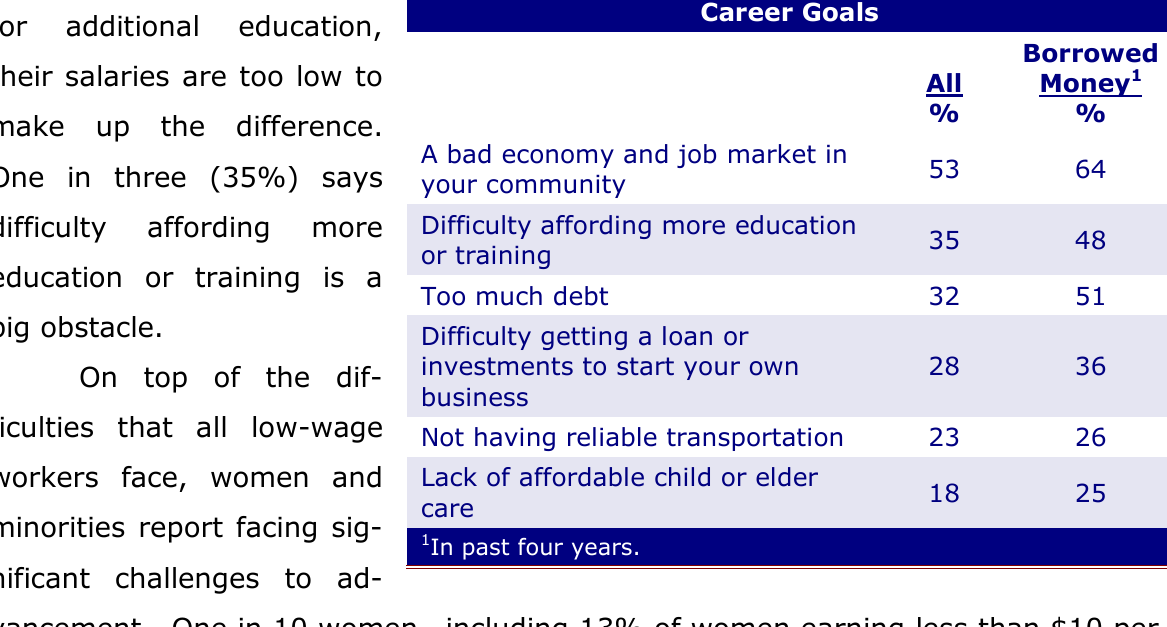
Table 8: Very or Fairly Big Obstacle to Reaching Career